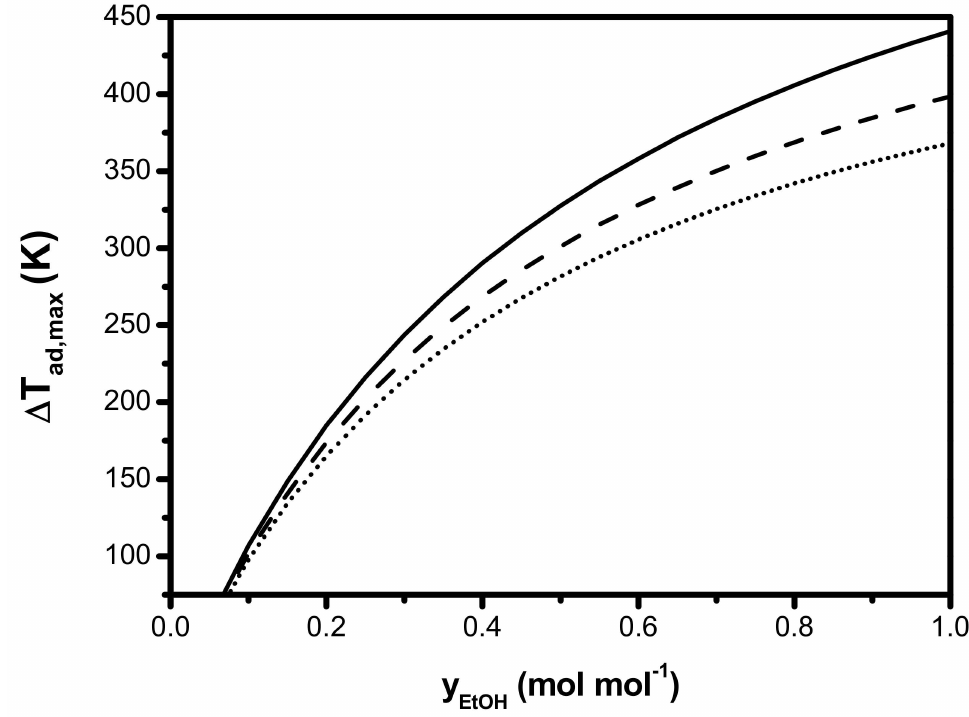
Figure 8. Maximum adiabatic temperature drop (Equation (34)) as a function of molar ethanol fraction in the feed for three di ff erent reactor inlet temperatures (full line: 573 K, dashed line: 673 K, dotted line: 773 K) and the process conditions indicated in Table